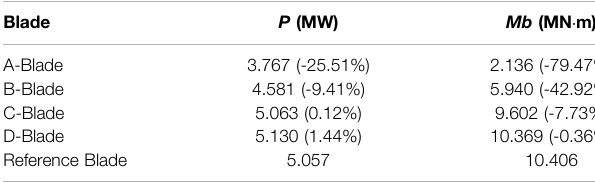
TABLE 2 | The comparison of the optimal solutions after two-objective optimization.